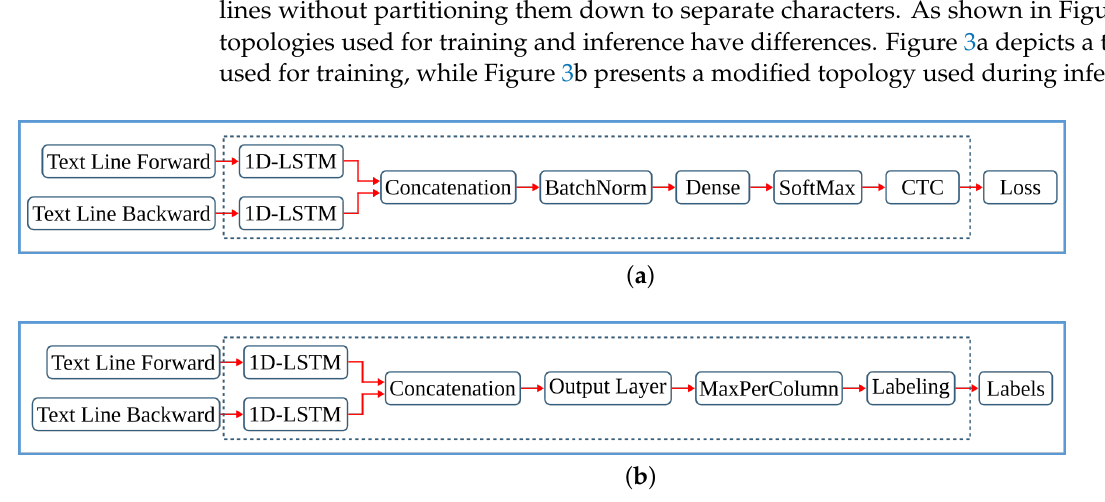
Figure 3. ( a ) Network topology used during training. Only forward path is shown. ( b ) Network topology used during